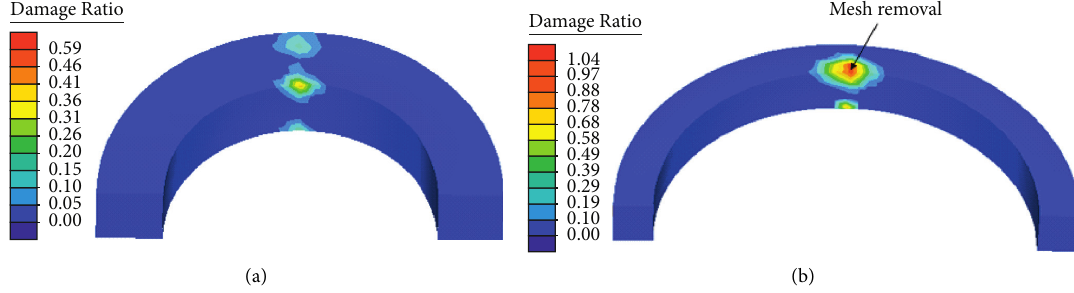
Figure 16: Damage ratio D distribution in hot ring rolling. (a) In the middle. (b) At the end of the